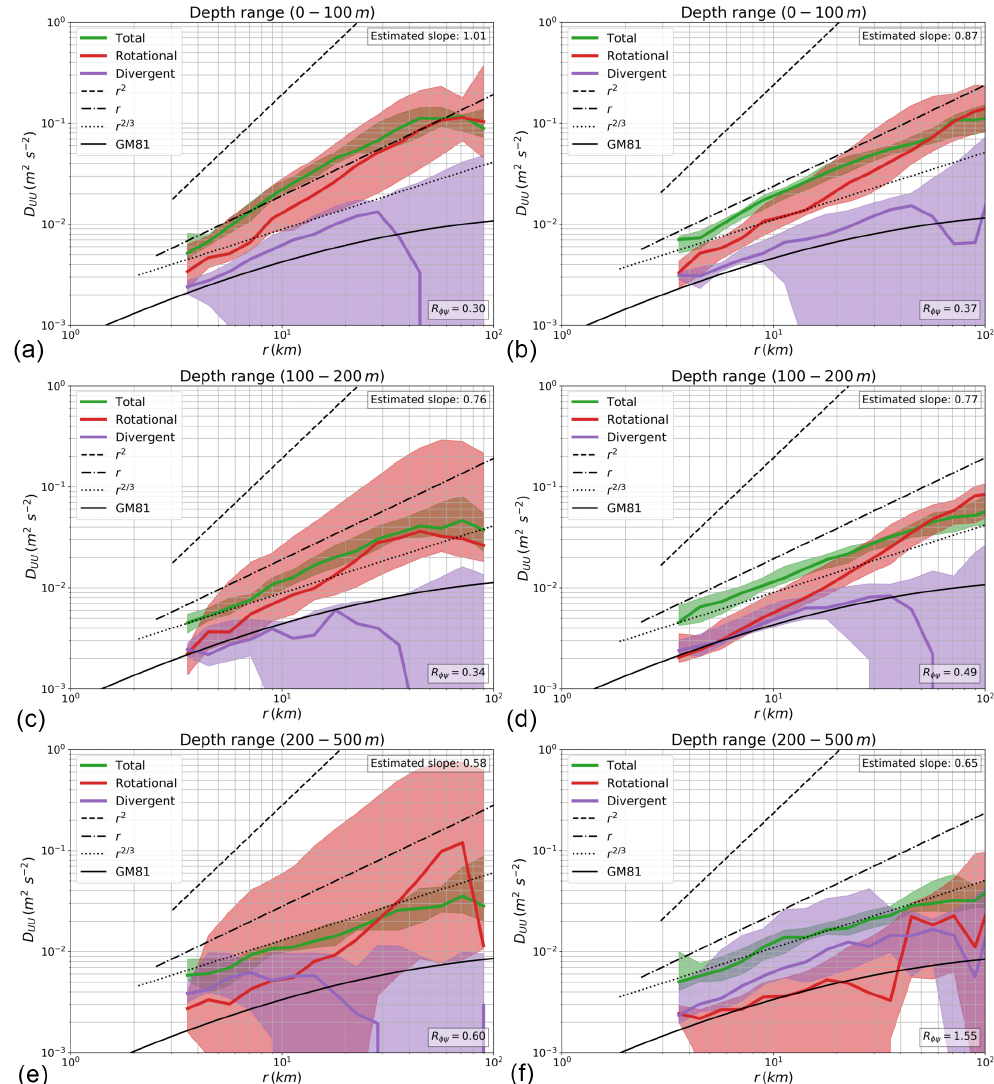
Figure 4. Mean velocity structure functions computed on each segment in the VAUB (a, c, e) and ECAL (b, d, f) regions plotted in the range of 3–100km. Longitudinal and transverse structure functions (not shown) are used to compute the total SFs (green curve) as well as the associated rotational (red) and divergent (purple) SFs. The total structure functions are also shown for each segment (shaded grey curves) inside the region of study. Classic power laws ( r 2 , r , r 2 / 3 ) are plotted for reference with oceanic turbulence theories as well as the GM spectrum structure function (GM81). Colour shading corresponds to confidence intervals at 5% and 95%, estimated from a bootstrap